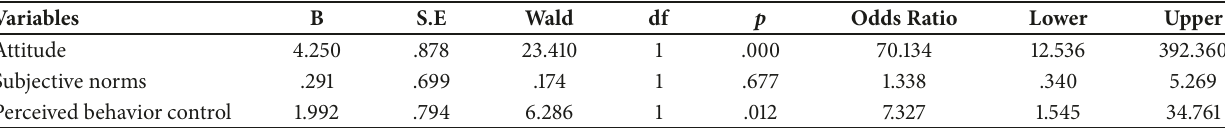
Table 4: The logistic regression predicting the likelihood of components of Theory of Planned Behavior to influence birth preparedness intention among pregnant women.